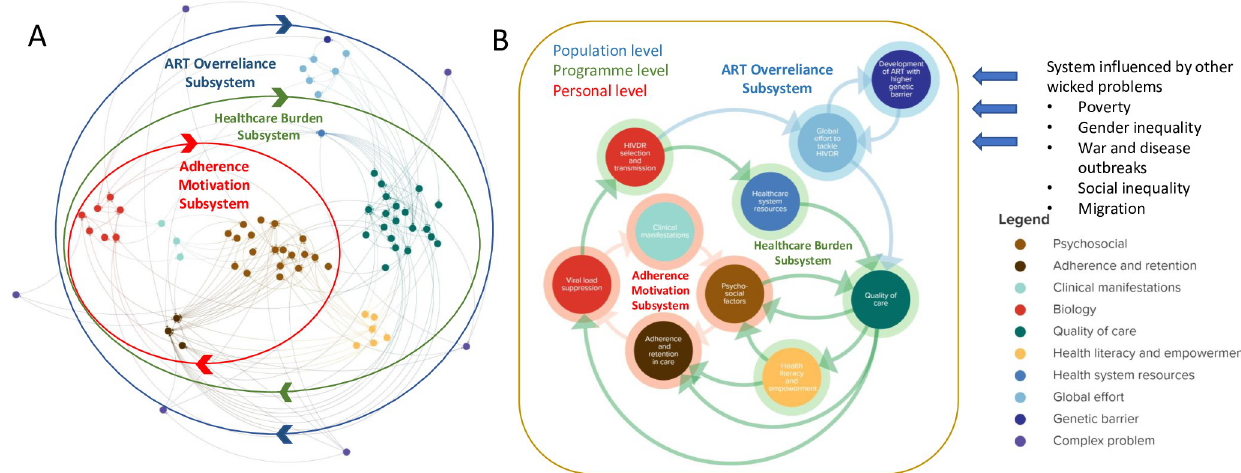
Fig 6. Summarizing a complex system. A) Detailed system of factors influencing HIVDR. The main feedback loops or subsystems are highlighted with colored circles. B) The same system, condensed into the main feedback loops and with the main exogenous factors represented on the outside. Each cluster in panel A is represented as a single element in panel B, represented with the same color in the core of the element. All connections between two clusters in panel A are represented as one connection in panel B. This way, the main dynamics of the system are represented in a more condensed and comprehensible format. Figure adapted from Kiekens et al. [19] and for illustrative purposes